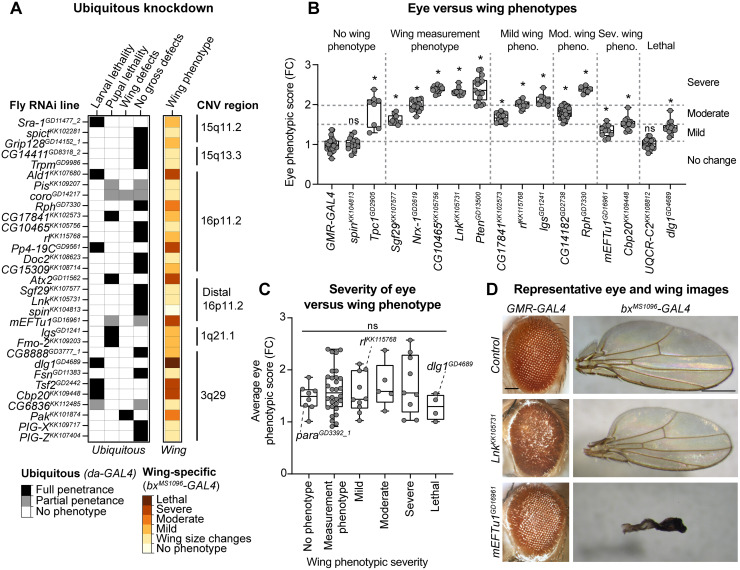
Comparison of wing-specific, eye-specific, and ubiquitous knockdown of fly homologs.(A) Heatmap with the penetrance of phenotypes with ubiquitous knockdown (da–GAL4) of select homologs of CNV genes, compared to their adult wing-specific (bxMS1096–GAL4) phenotypic severity, is shown. (B) Boxplots of Flynotyper-derived phenotypic scores for adult eyes with eye-specific knockdown (GMR-GAL4) of select fly homologs, normalized as fold-change (FC) to control values, are shown (n = 7–40, *p < 0.05, one-tailed Mann–Whitney test with Benjamini-Hochberg correction). Boxplots are arranged by severity of adult wing phenotypes, while eye phenotypic scores are categorized by severity: no change (0–1.1 FC), mild (1.1–1.5 FC), moderate (1.5–2.0 FC), and severe (>2.0 FC). (C) Boxplot shows average eye phenotypic scores for 66 RNAi lines of select fly homologs, normalized as FC to control values, according to wing phenotypic category (n = 4–30 RNAi lines per group). We did not observe significant changes in eye phenotype severity across the five wing phenotypic categories (Kruskal-Wallis rank sum test, p = 0.567, df = 5, χ2 = 3.881). Examples of average eye phenotypic scores for RNAi lines with no phenotype (paraGD3392_1), mild (rlKK115768), and lethal (dlg1GD4689) wing phenotypes are highlighted. Boxplots indicate median (center line), 25th and 75th percentiles (bounds of box), and minimum and maximum (whiskers), with red dotted lines representing the control median. (D) Representative brightfield adult eye (scale bar = 100 μm) and wing (scale bar = 500μm) images with tissue-specific knockdown of CNV homologs are shown. Genotypes for the eye images are: w1118;GMR-GAL4/+; UAS-Dicer2/+, w1118;GMR-GAL4/UAS-LnkKK105731
RNAi; UAS-Dicer2/+, w1118;GMR-GAL4/UAS-mEFTu1GD16961
RNAi; UAS-Dicer2/+. Genotypes for the wing images are: w1118/bxMS1096-GAL4;+; UAS-Dicer2/+, w1118/bxMS1096-GAL4; UAS-LnkKK105731
RNAi/+; UAS-Dicer2/+, and w1118/bxMS1096-GAL4; UAS-mEFTu1GD16961
RNAi/+; UAS-Dicer2/+.